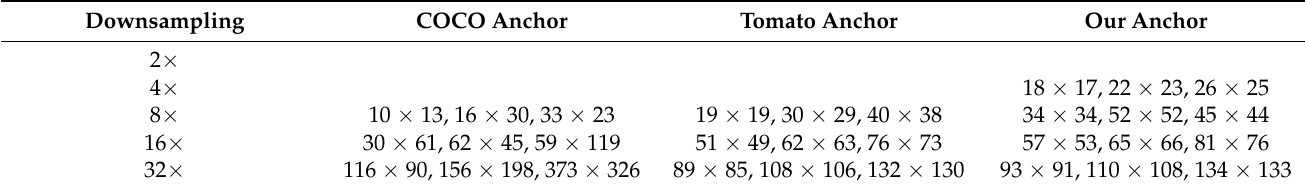
Table 3. A set of anchor values for COCO, tomato, and tomato small-target detection. Downsampling COCO Anchor Tomato Anchor Our Anchor 2